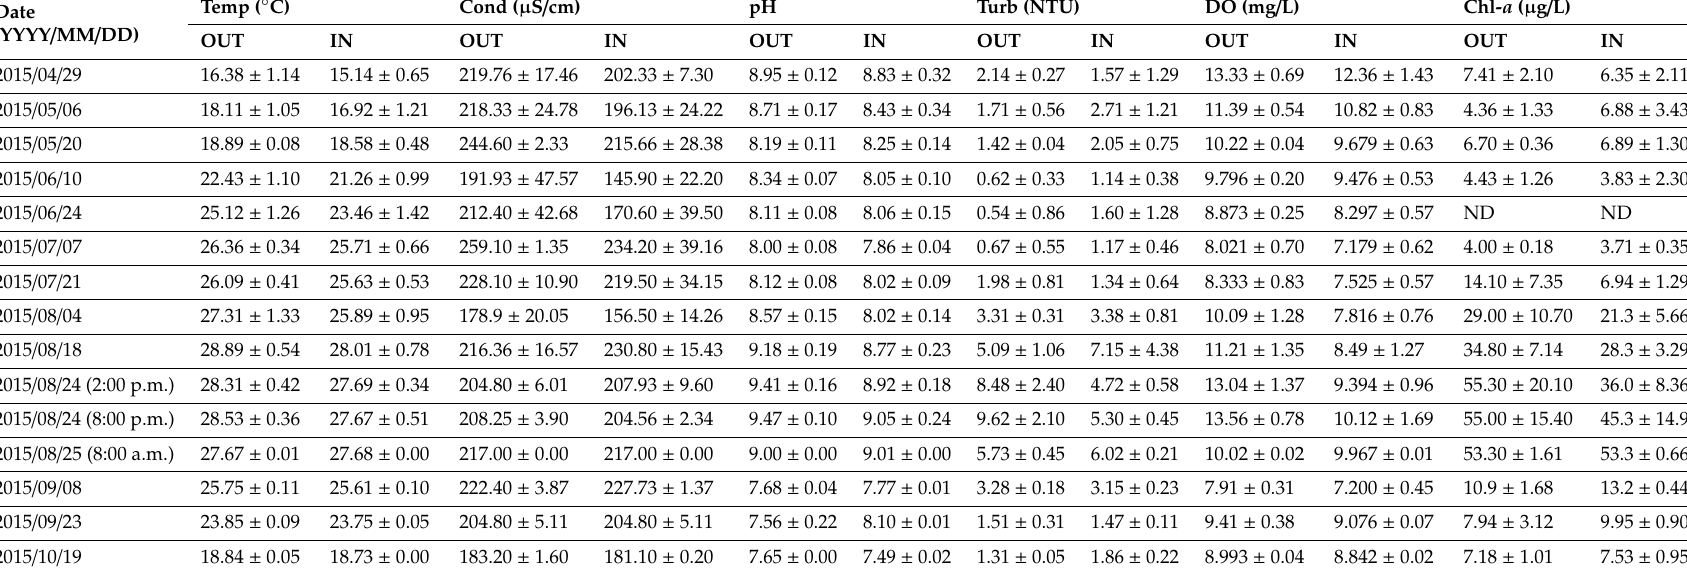
Table 3. E ff ects of an alternative algae-blocking mat (ABM) on temperature (Temp), conductivity (Cond), pH, turbidity (Turb), dissolved oxygen (DO), and chlorophyll- a (Chl- a ) over daily (24–25 August) and monthly monitoring between 29 April and 19 October 2015. OUT, reservoir water; IN, ABM-passed water; ND, no data. NTU: nephelometric turbidity